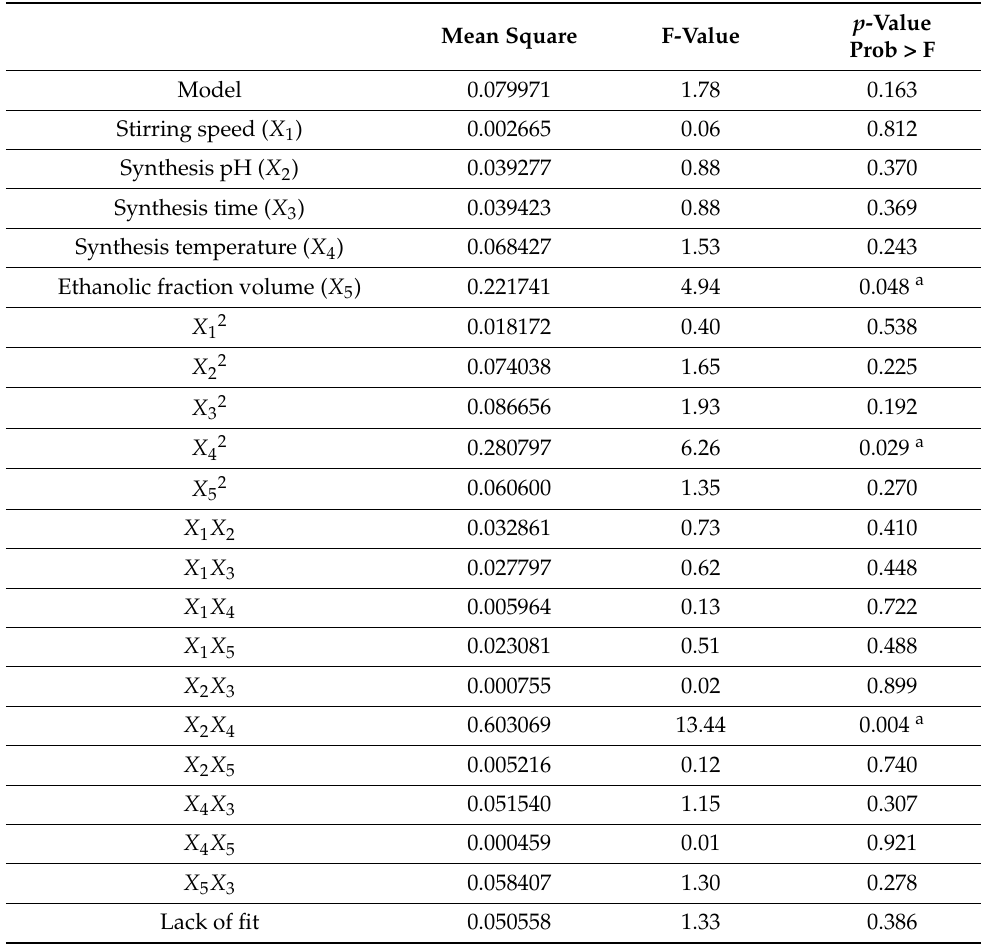
Table 4. ANOVA for response surface quadratic model for AgNPs